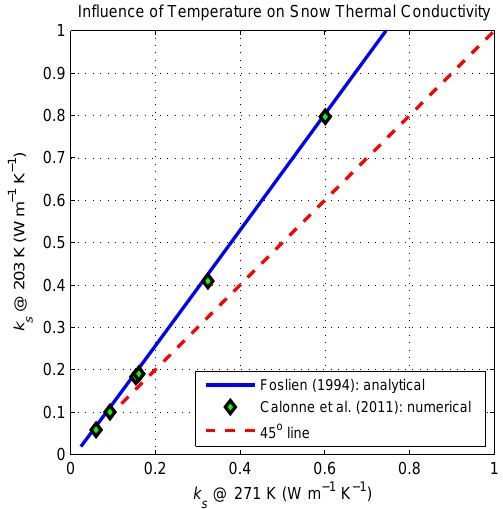
Figure 6. The influence of temperature on thermal conductivity as predicted by the model of Foslien (1994) and Calonne et al. (2011) through finite element